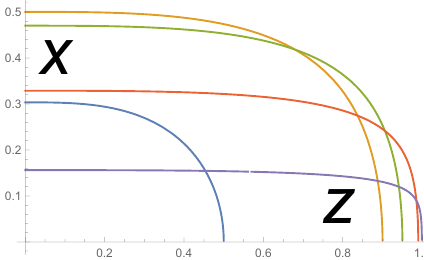
Figure 25 . The profile of the EOW brane in BTZ. The blue, yellow, green, red and purple curve corresponds to z ∗ = 0 . 5 , 0 . 9 , 0 . 95 , 0 . 99 and 0 . 999 , respectively. We set a = 1